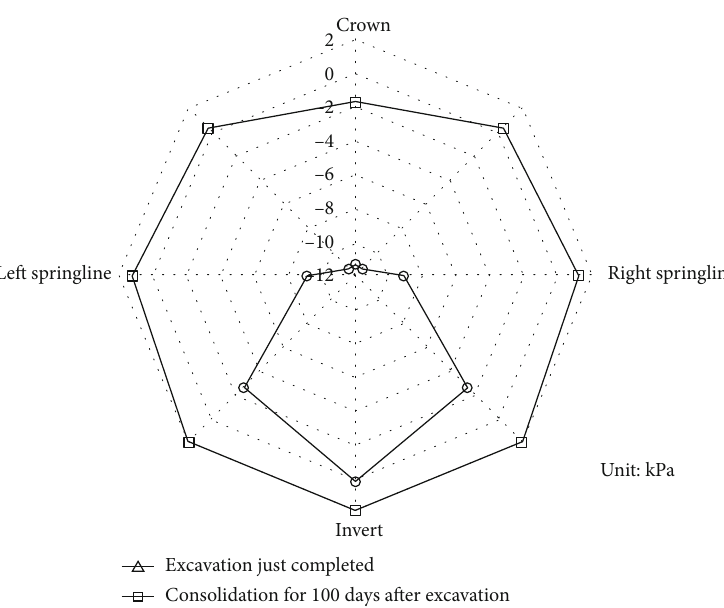
Figure 5: Earth pressure change around tunnel lining in